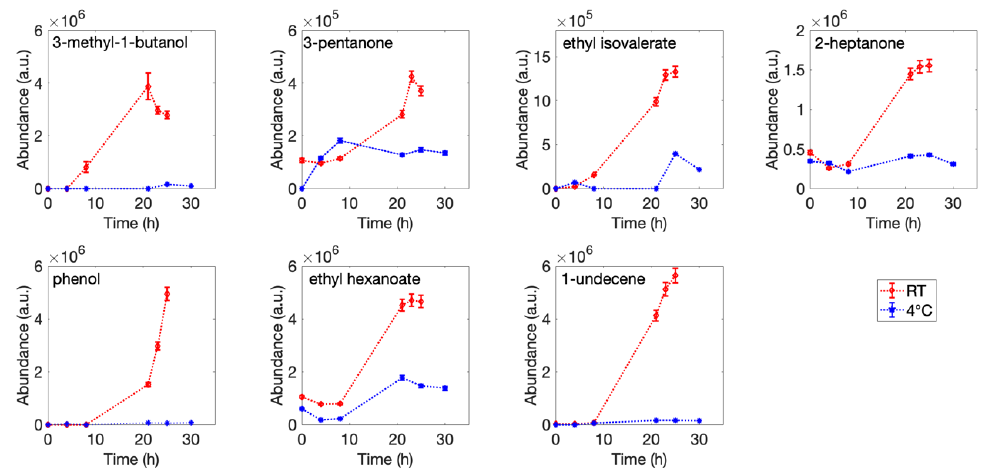
Figure 3. SPME-GC/MS analysis of fish samples stored at 4 °C and 25 °C. Time dependence of the abundance of the most meaningful compounds (see text for details) present in the headspace for fish stored at room temperature (25 ◦ C) and inside the fridge (4 ◦ C).